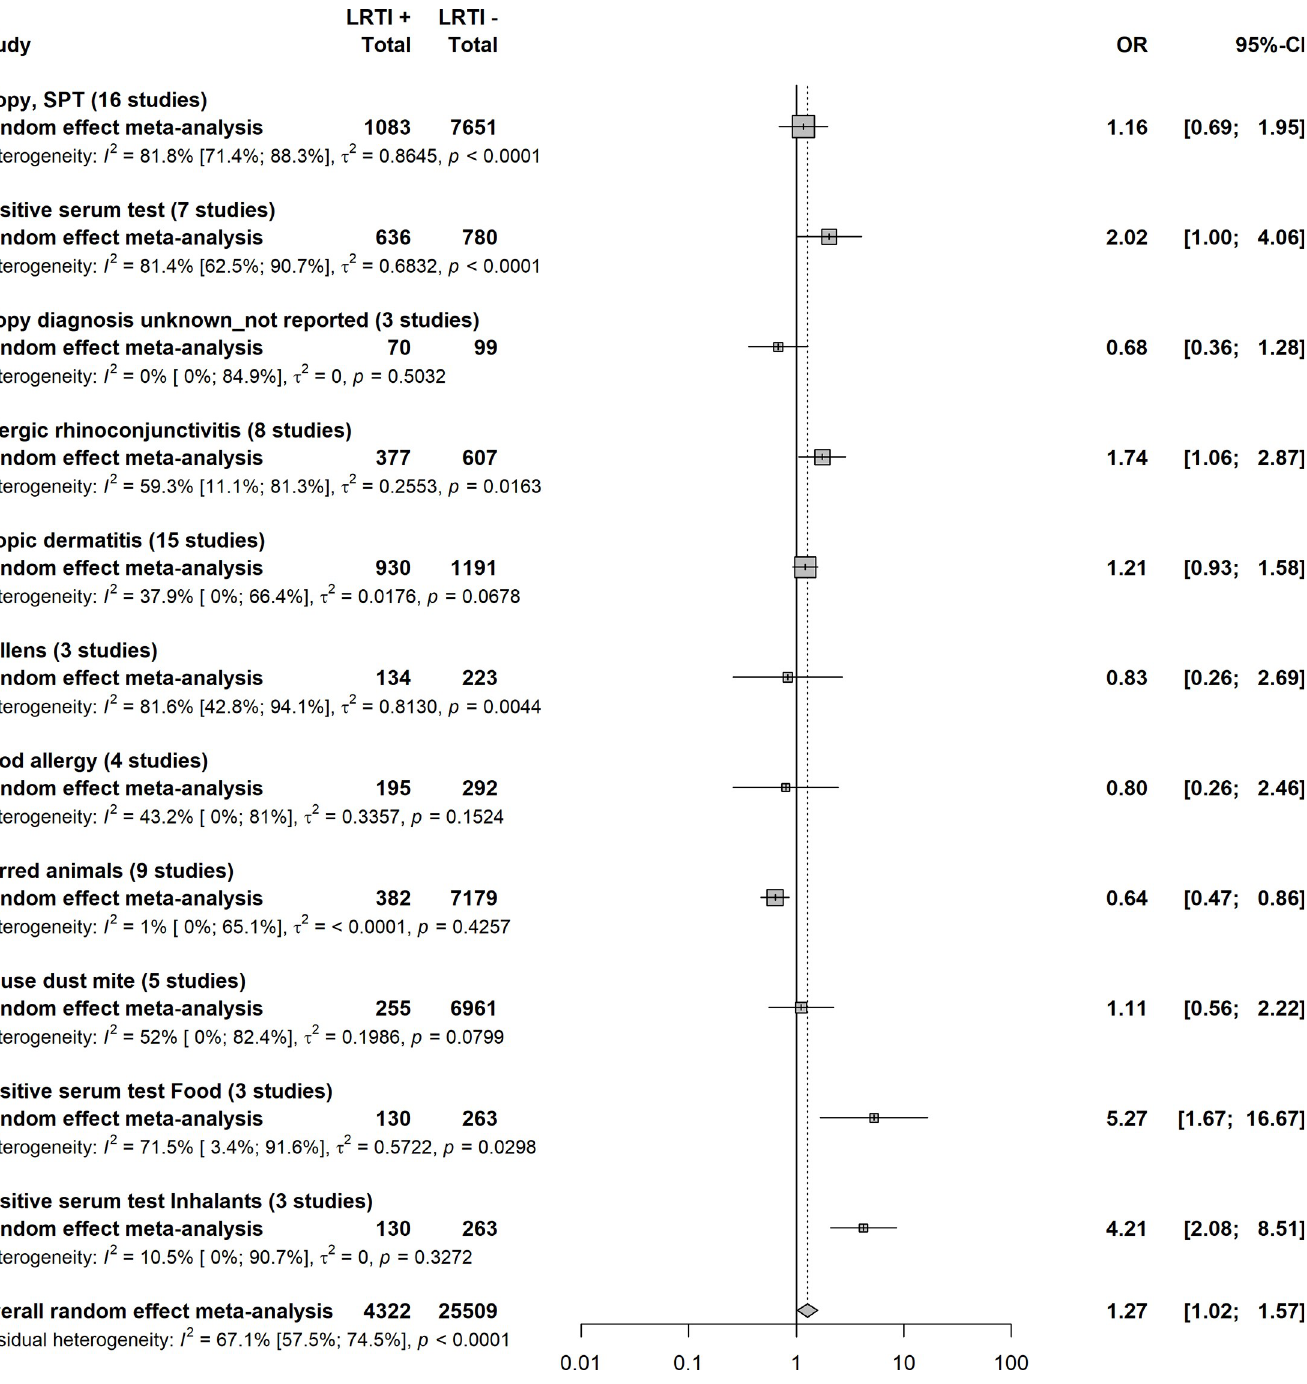
Fig 2. Comparison of atopy in people with and without LRTI in